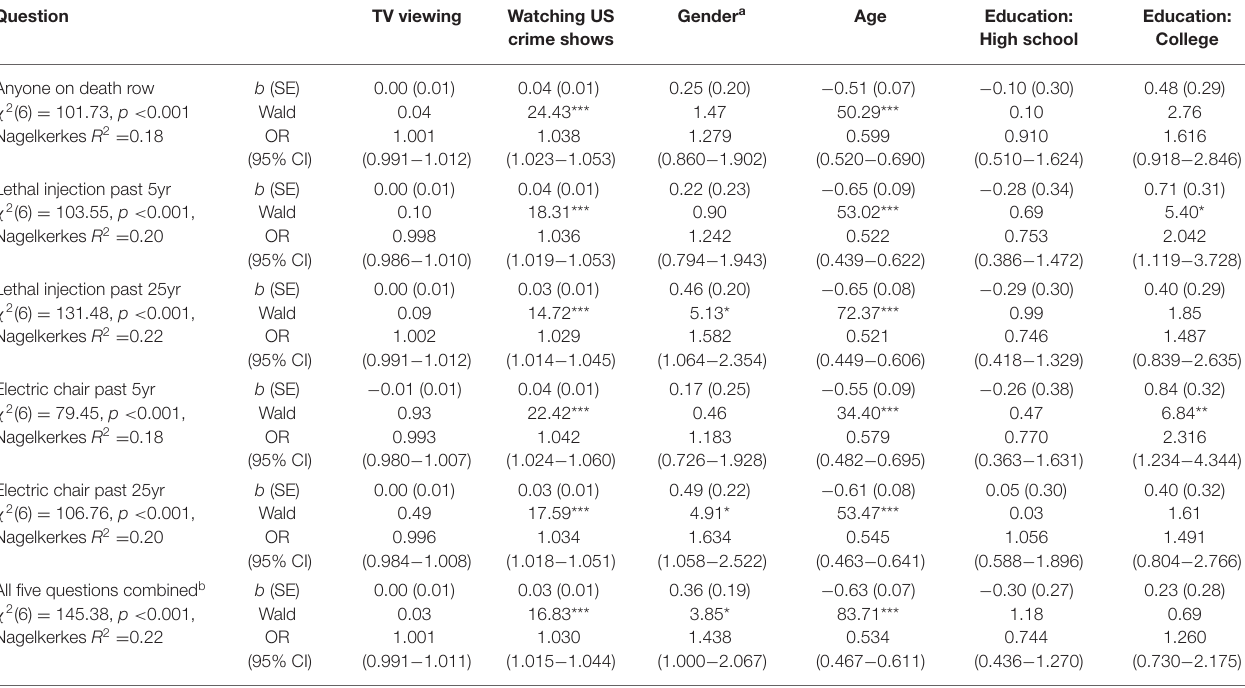
TABLE 3 | Results of binary logistic regression analyses to predict perceptions of the death penalty among study participants. Question TV viewing Watching US